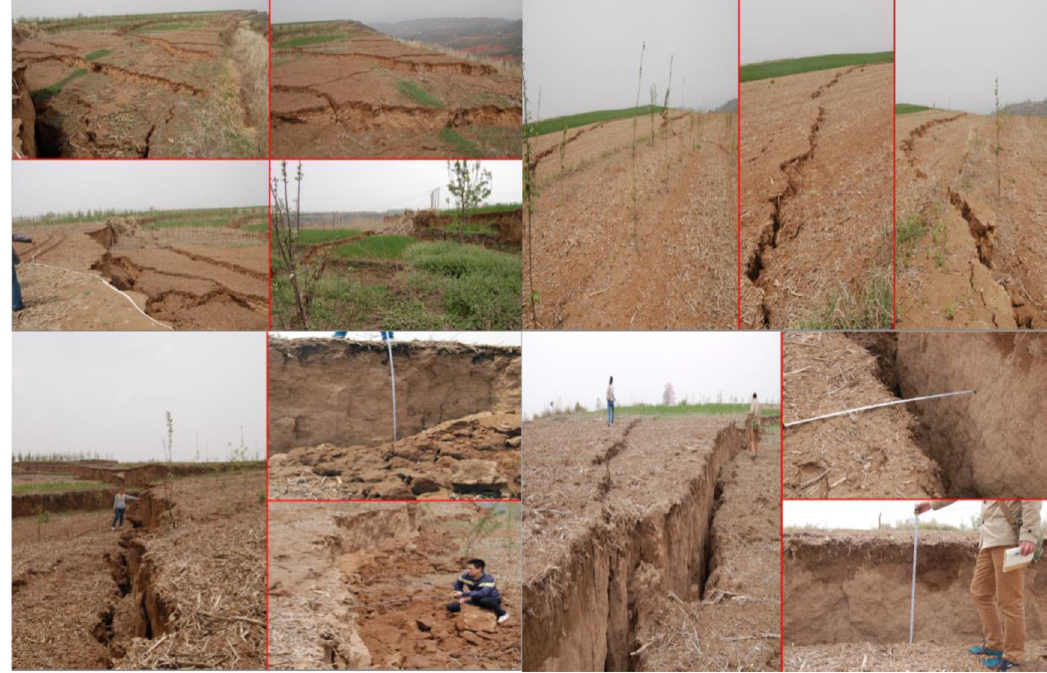
Figure 3. Surface damage caused by underground mining.